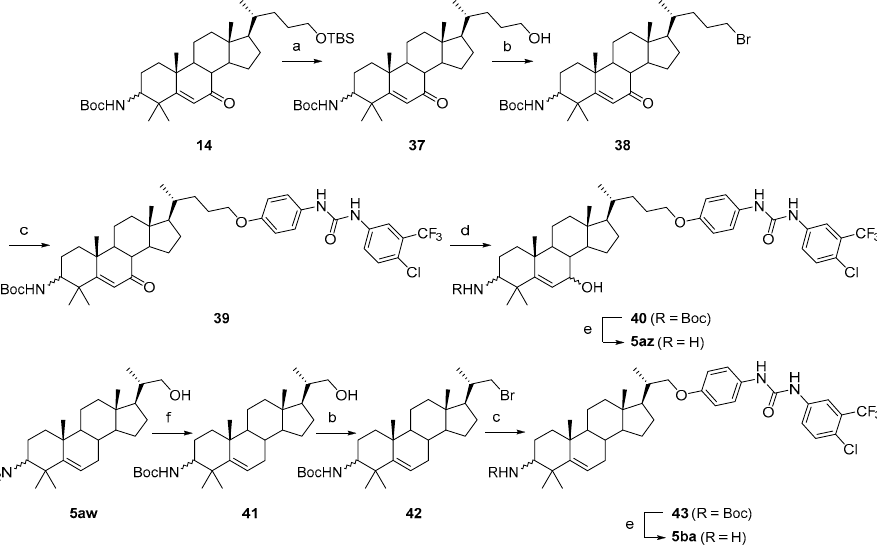
Scheme 7. Synthesis of compounds 5ax-ay . Reagents and conditions: (a) DCM, r.t., 96–99%. (b) CBr 4 ,